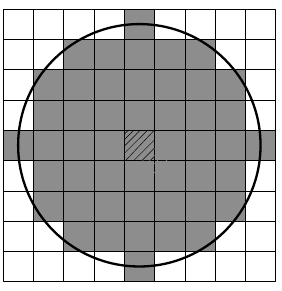
Figure 2. Moving average filter (9 9) for an image of 250 m resolution. The hatched center cell represents the ship, the solid line circle with 1 km radius represents the observation range, and the pseudo ‐ ship observation (PSO) sea ice concentration (SIC) is obtained from the grey cells.